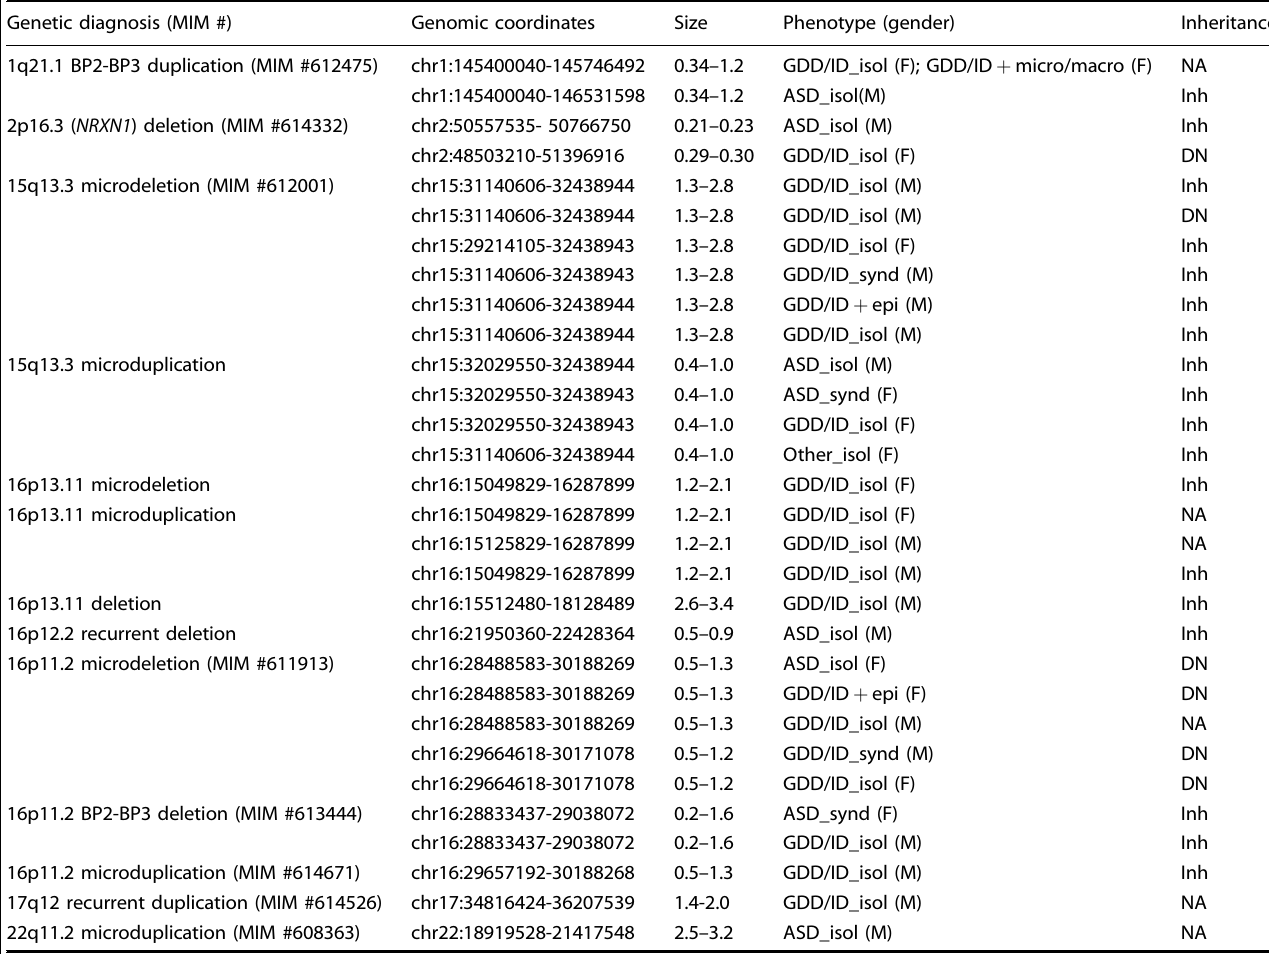
Table 3. Pathogenic variants with incomplete penetrance identi fi ed in the solved patients. Genetic diagnosis (MIM